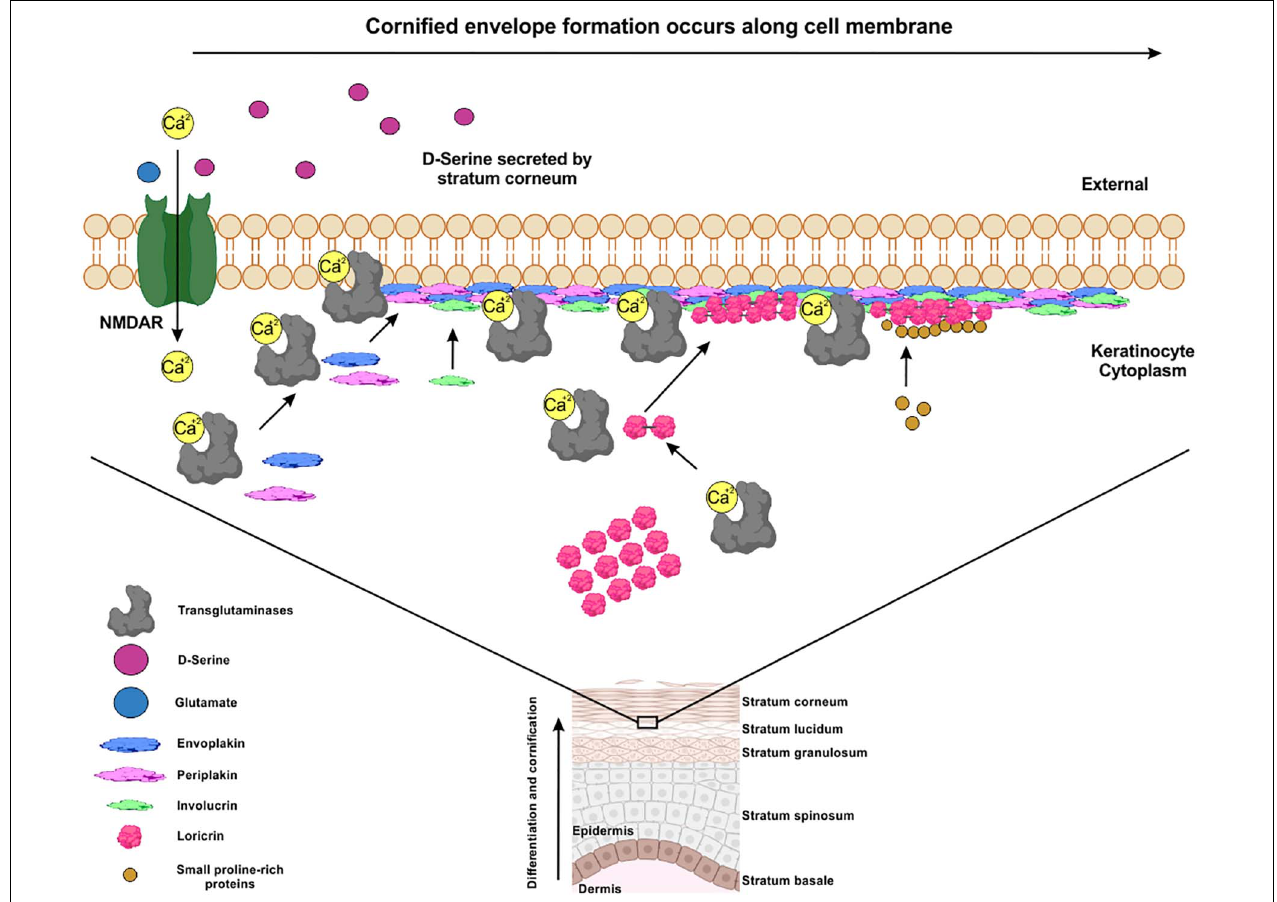
FIGURE 2 | Early stages of the cornified envelope formation are calcium-deppendent. The crosslinking between Envoplakin, Periplakin, Involucrin, Loricrin and Small-prolin-rich proteins, are mediated by calcium-dependent TGs through the formation of covalent bonds. This resulted in the formation of a layer along the entire inner surface of the plasma membrane, forming a scaffold to which other precursors are added to form a mature cornified envelope (CE). D-serine secreted in stratum corneum by corneocytes can activate NMDAR expressed in keratinocytes in a paracrine way improving the differentiation and cornification of